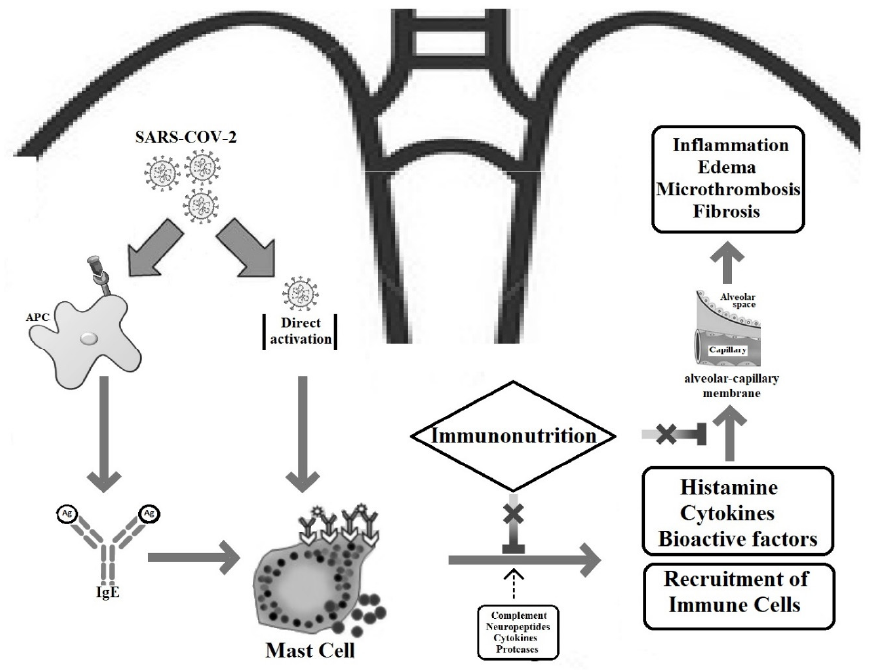
Figure 1. Schematic representation of the modulatory activity of immunonutrients with potential use in COVID-19 on mast cells and histamine during SARS-CoV-2 infection. APC: antigen-producing cells (macrophages or dendritic cells).